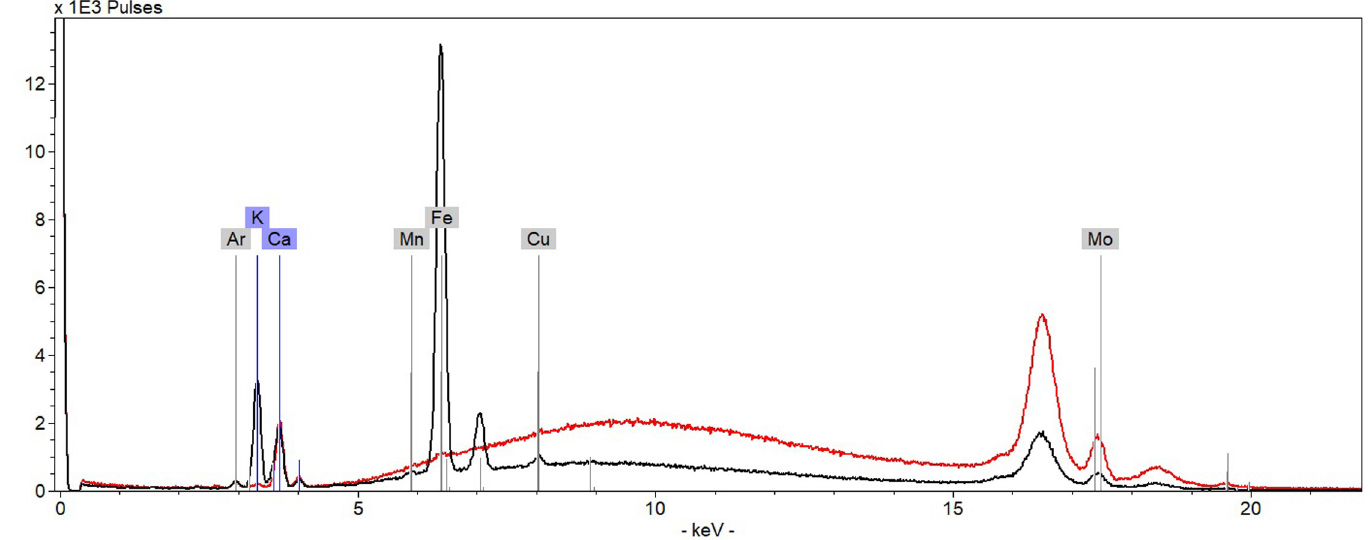
Fig 21. XRF spectra from K408 1556. Accumulated spectra (5 points) of paper (red spectrum) and Christina’s writing ink line 4 (black spectrum).